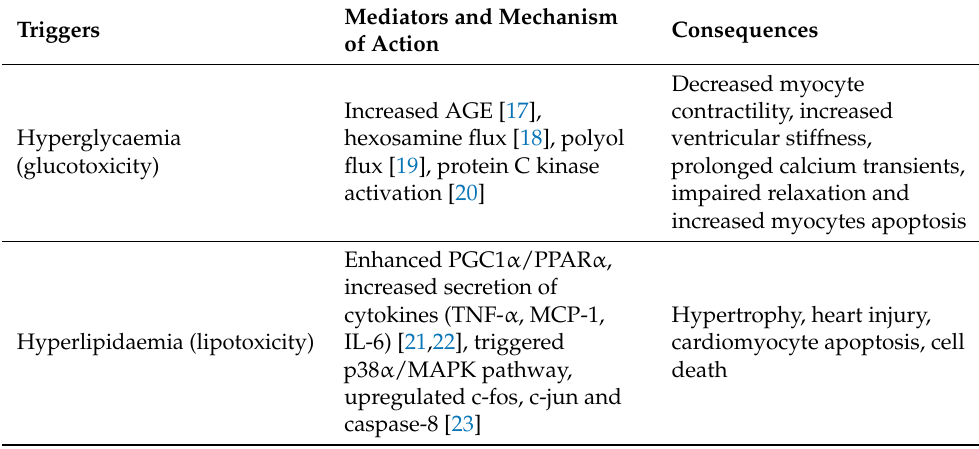
Table 1. Metabolic changes leading to diabetic